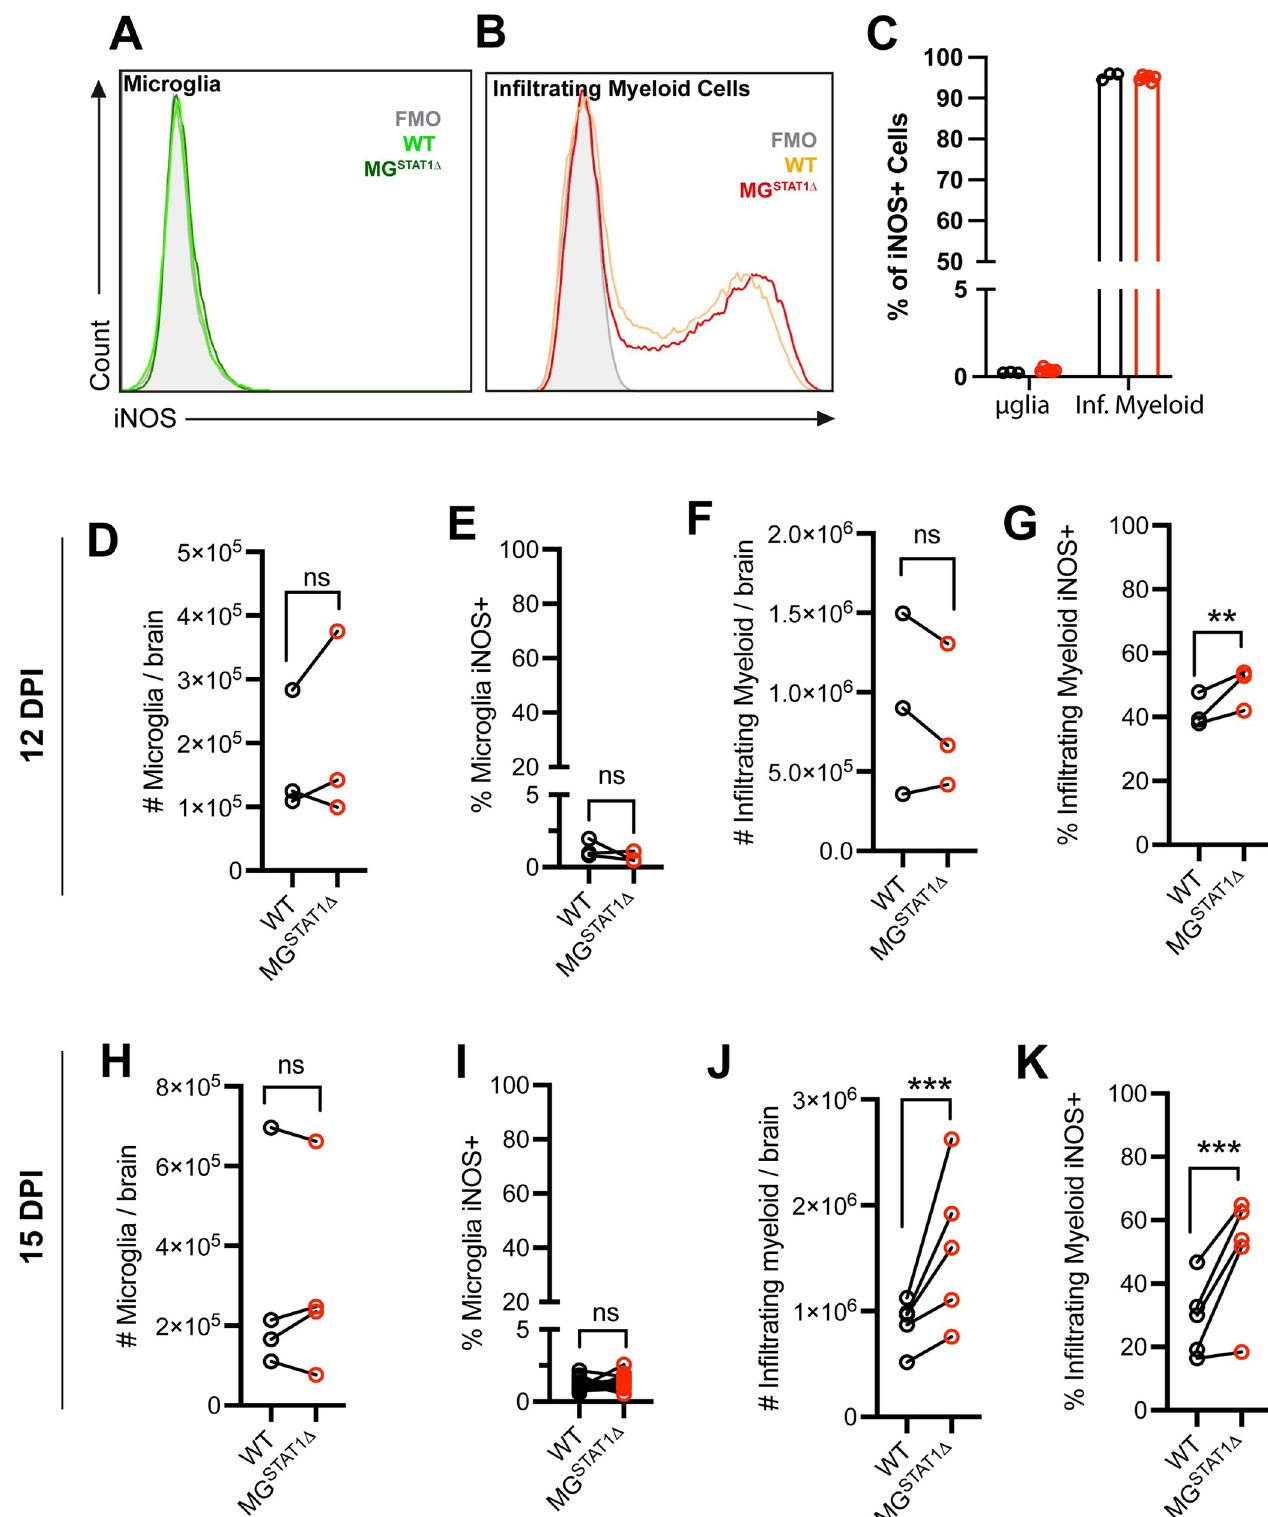
Fig 3. Brain-infiltrating myeloid cells, but not brain-resident microglia, express iNOS during T . gondii challenge. WT and MG STAT1 Δ mice were intraperitoneally infected with 10 cysts of the Me49 strain of T . gondii and brains were analyzed by flow cytometry. Representative histograms indicating iNOS